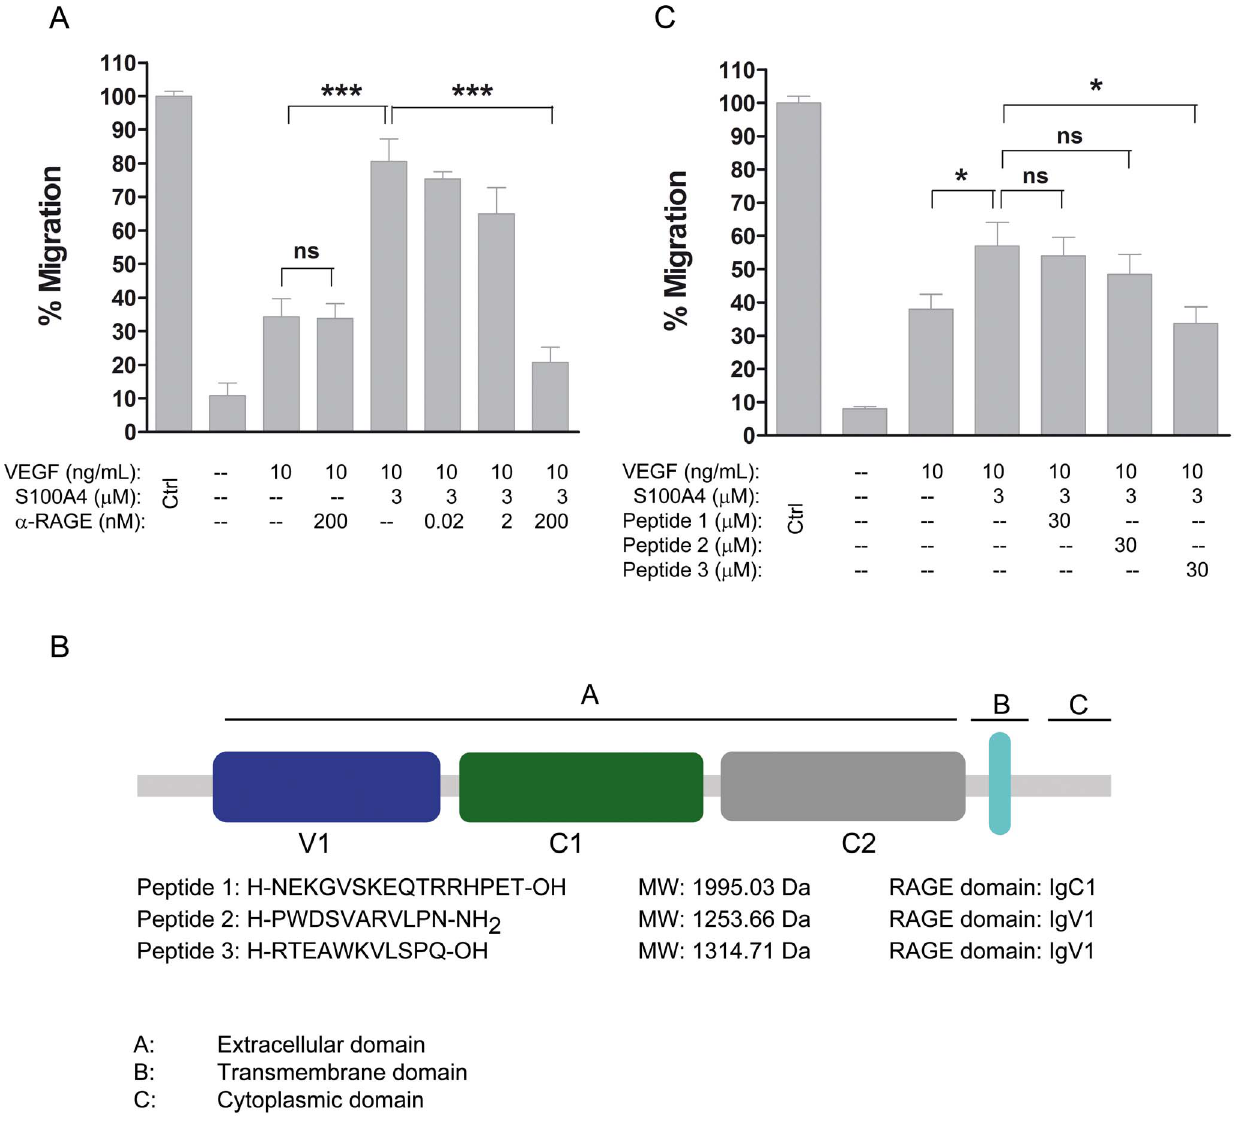
Figure 2. S100A4 acts via RAGE on EC migration. A) Dose-response activity of anti-RAGE (0.02–200 nM) on HUVEC migration. After starvation, cells were incubated with an anti-RAGE mAb for 2 h and then treated with VEGF (10 ng/mL) or VEGF plus S100A4 (3 m M), respectively, for 24 h. B) Design of homologous peptides to the extracellular domains of RAGE. C) Before migration, peptides were incubated with S100A4 for 2 h at 37 u C, then HUVEC were treated with VEGF (10 ng/mL) or VEGF plus S100A4 (3 m M) with 30 m M of each peptide respectively for 24 h. Each data point was normalized to the positive control (left bar) that represents 100% migration. Bars show the mean 6 SEM. ns p . 0.05, * p , 0.05, *** p , 0.001.